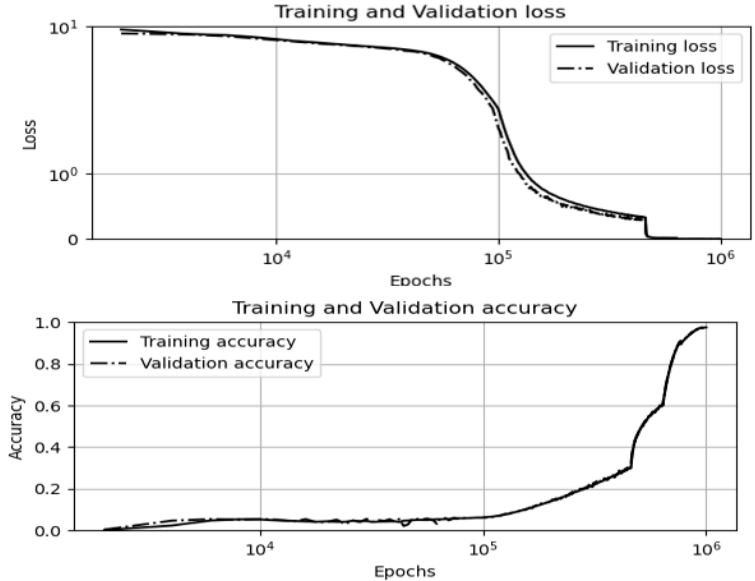
Figure 6. Loss and accuracy of training and validation for the deep neural network.